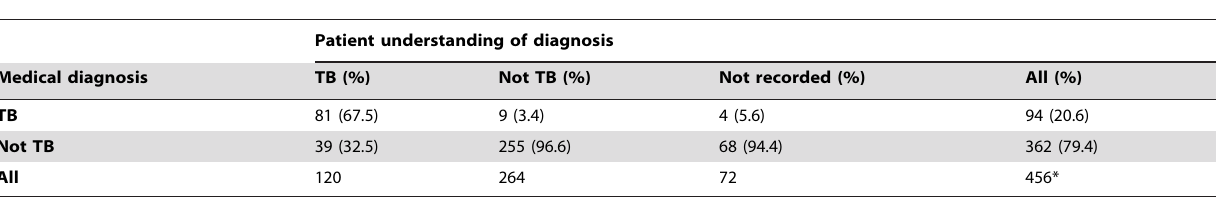
Table 3. Agreement between the diagnosis reported by the patient and the doctor (Questionnaire